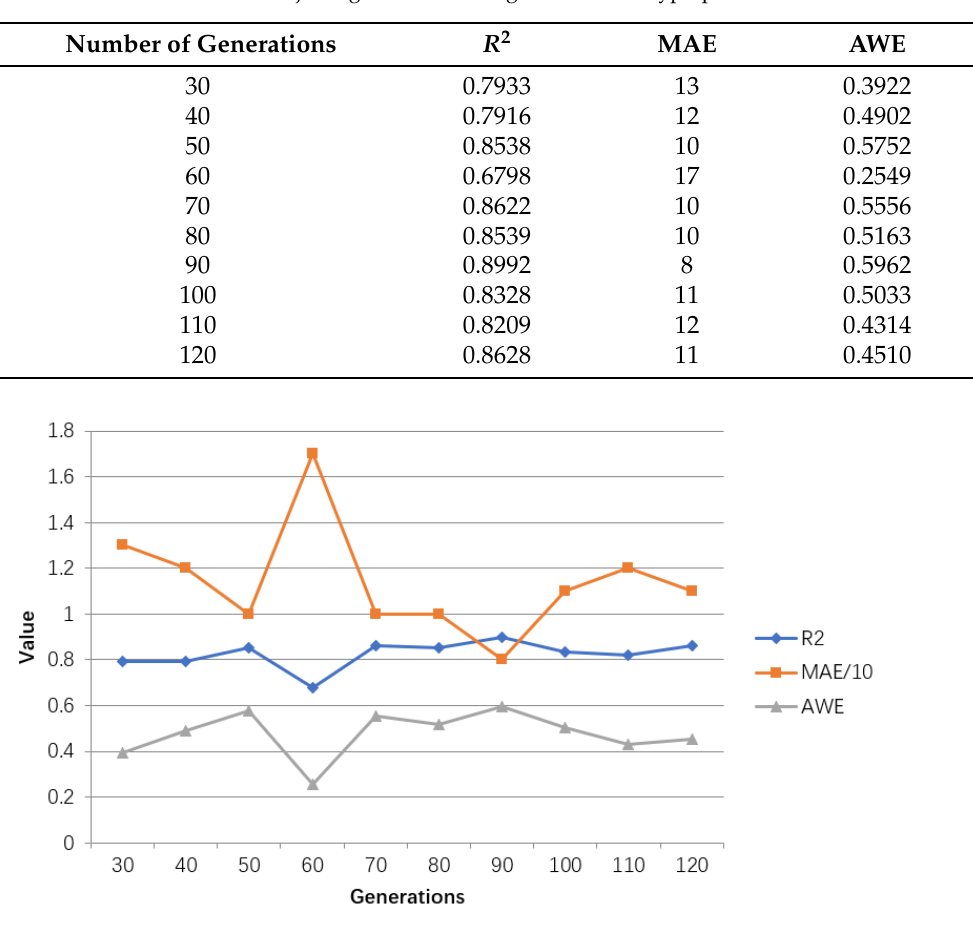
Table 5. Evaluation table for adjusting the number of generations of hyperparameters in GA-BP model.